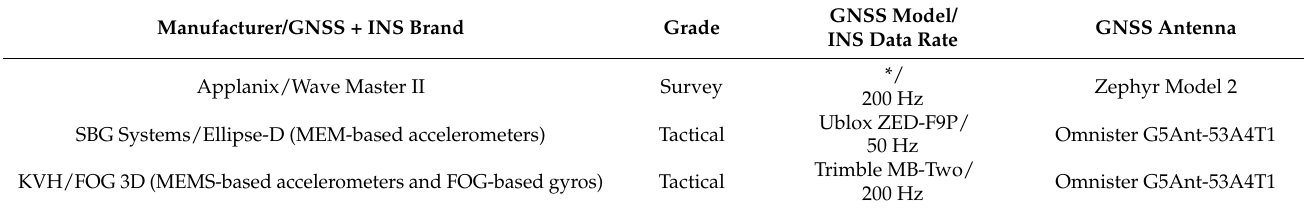
Table 1. GNSS + INS sensors and antennas deployed during the experiment.